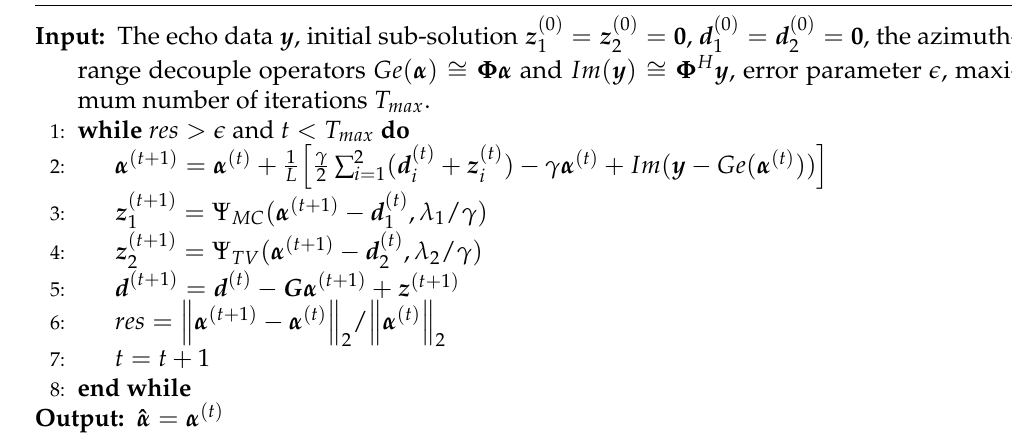
Algorithm 1 Variable splitting and modified ADMM for nonconvex and total variation